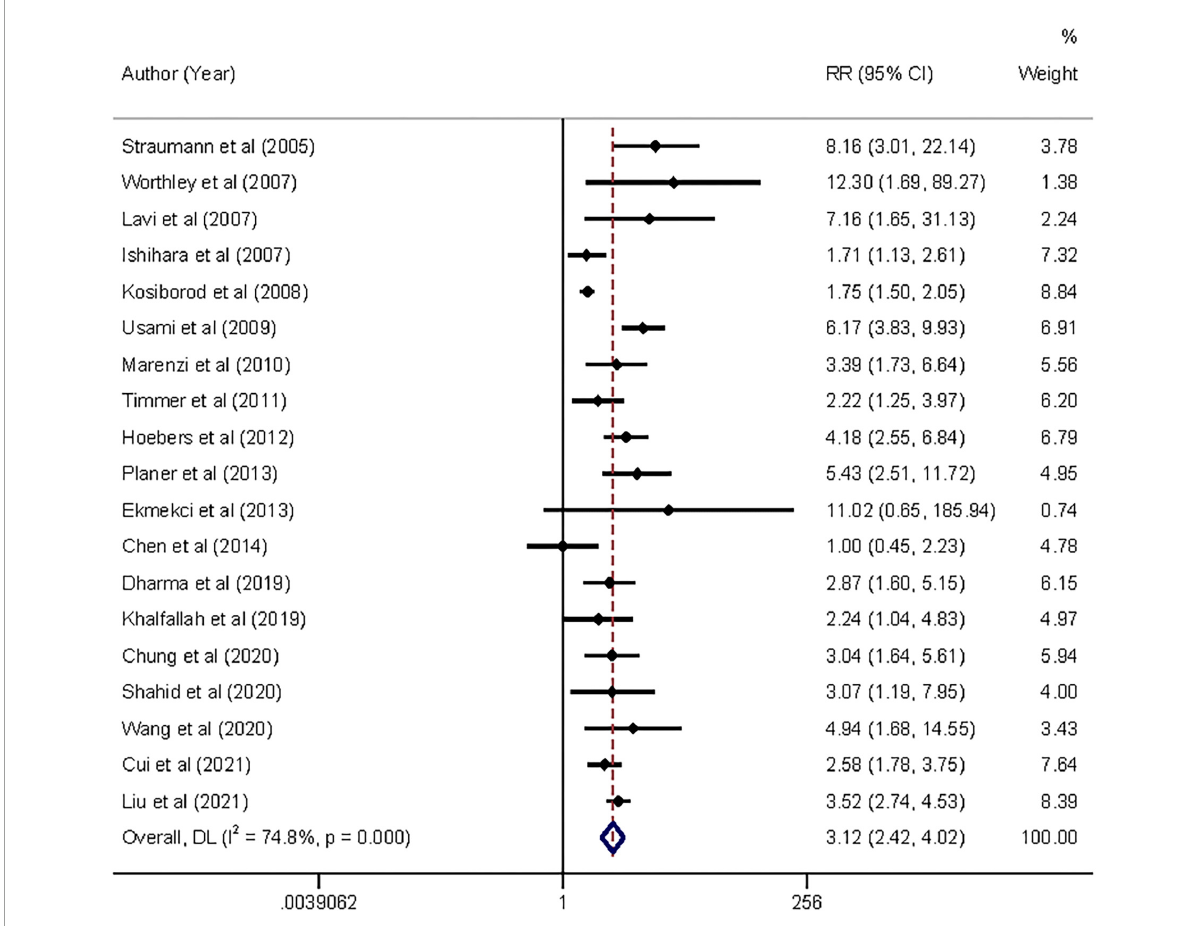
FIGURE2 Forrest plot of admission hyperglycemia associated with the short-term all-cause mortality risk. Weights are from random-effects model.